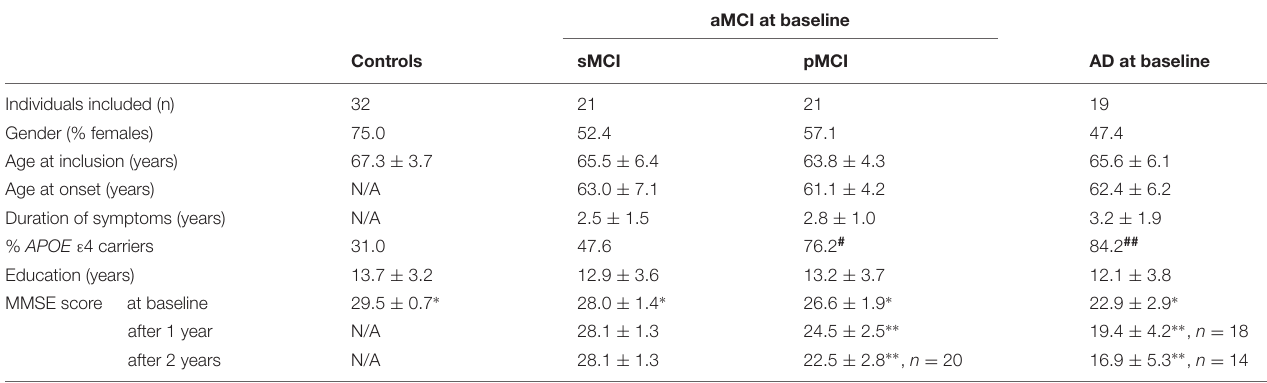
TABLE 1 | Demographic data.